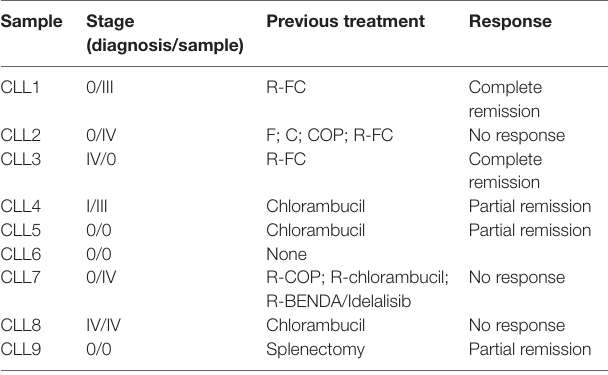
TaBle 1 | characteristics of cll patients used in the study of compatibility. sample stage Previous treatment (diagnosis/sample)